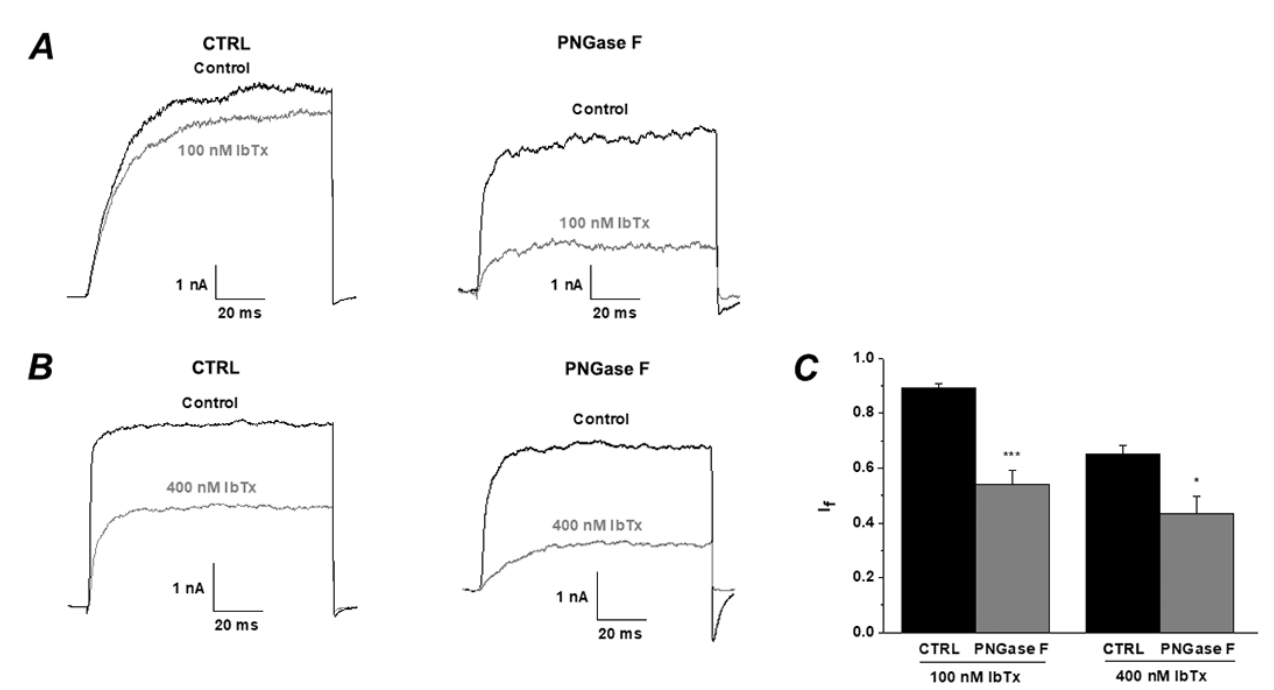
Figure 6. The application of PNGase F enhances the inhibitory effects of IbTX on BK ( α + β 1) channel. (A-B) Whole-cell current traces from deglycosylation BK channels before and after the application of IbTx (A) 100 nM and (B) 400 nM without treatment (left, CTRL) or pretreatment with PNGase F (right, PNGase